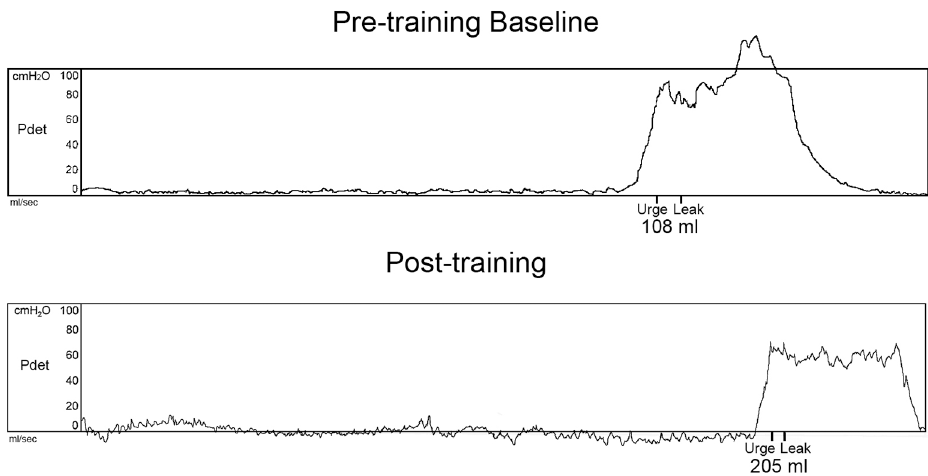
Fig 2. Detrusor pressure recording example. Raw recording of detrusor pressures (Pdet) from research participant A57 for the initial fill cycle pre-training and post-training. Note that the urge sensation precipitated by the rise in the bladder pressure immediately preceded the onset of leak, which occurred at almost twice the fill volume post-training. On the pre-training fill/void cycle, the leak occurred at 05:54 (min:sec), while post-training the leak occurred at 10:33 (20 ml/min–constant fill